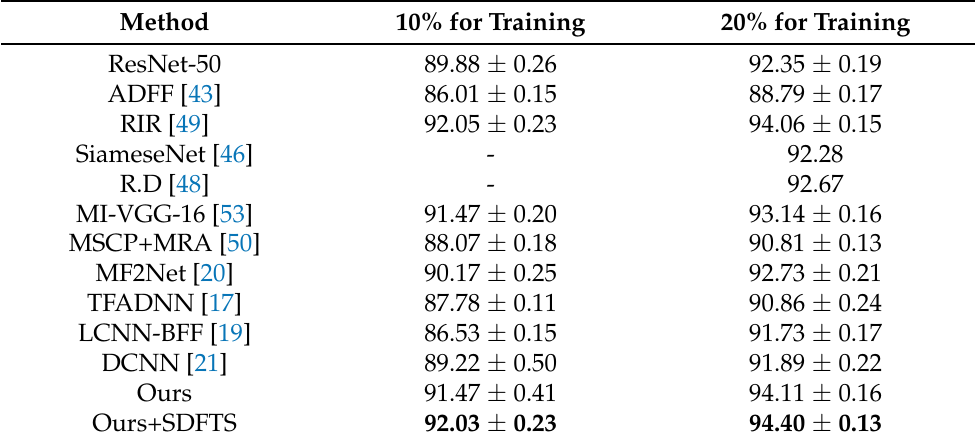
Table 8. The performance comparison for the NWPU-RESISC 45 dataset. SDFTS represents the stochastic decision-level fusion training strategy. The bold values denote the best performance of different training